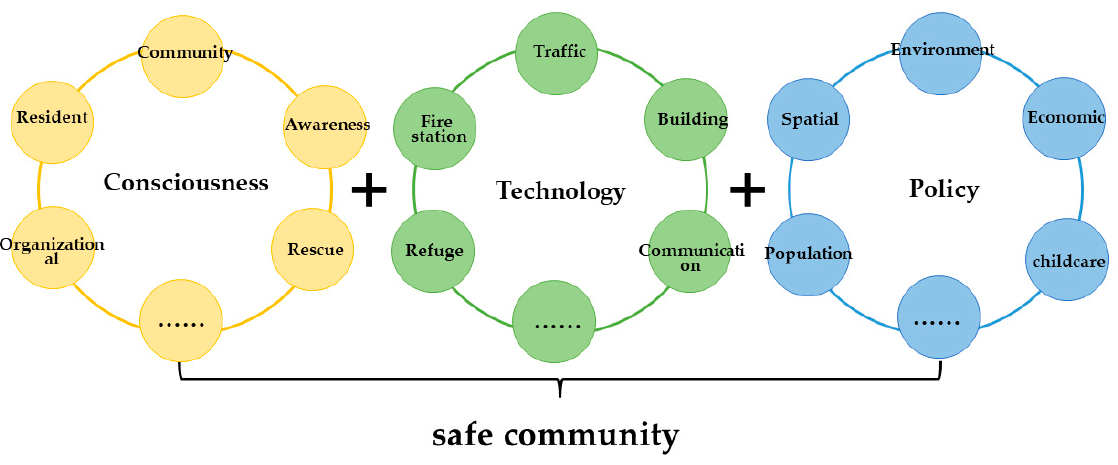
Figure 1. The specific conceptual